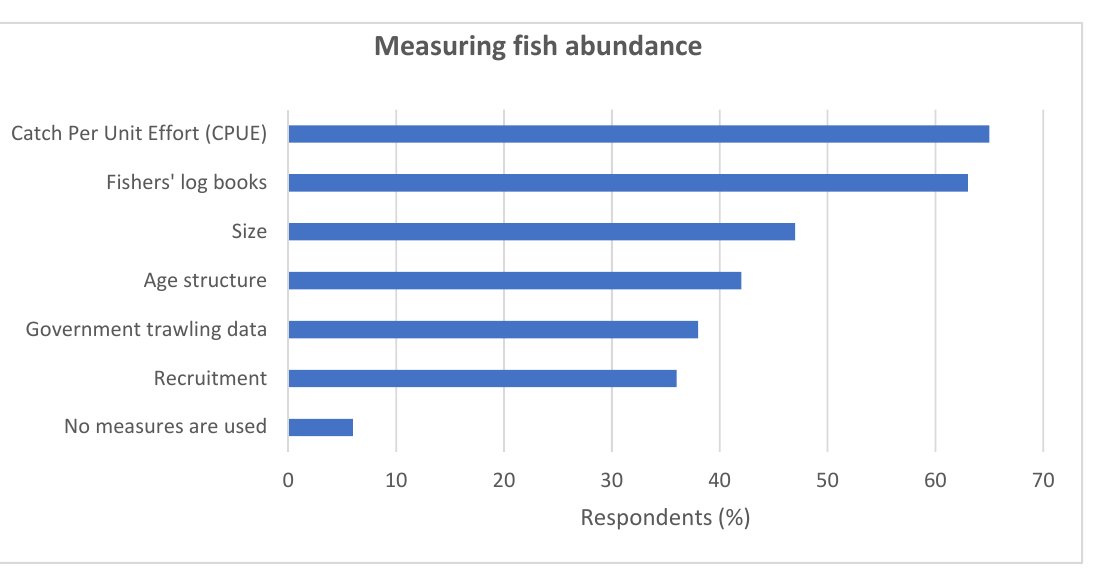
Figure 15. The prevalence of different approaches to measuring fish abundance.